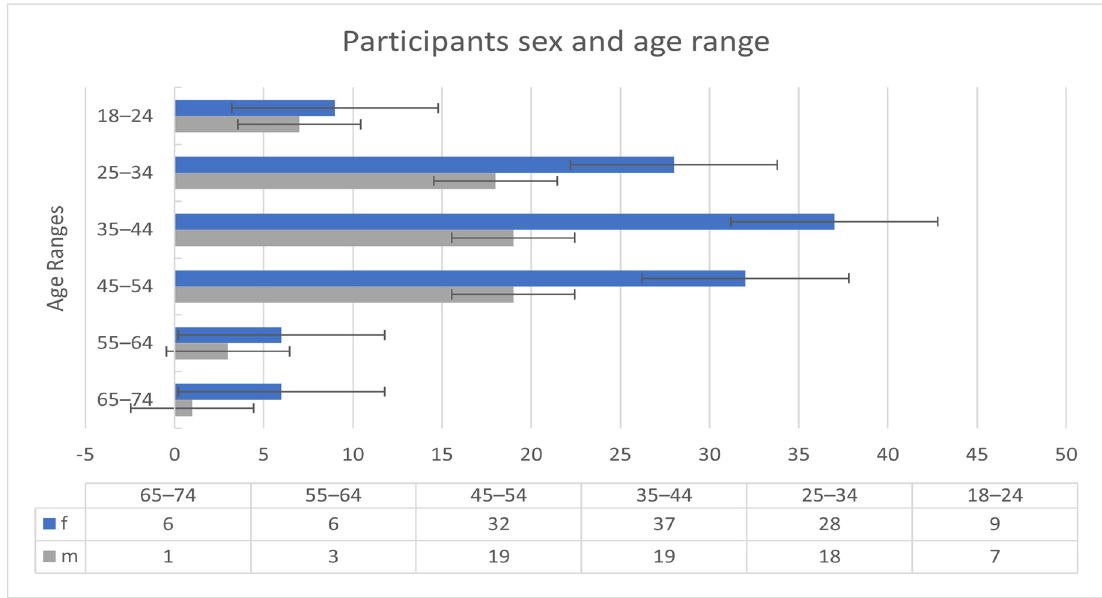
Figure 1. Participants demographic information.